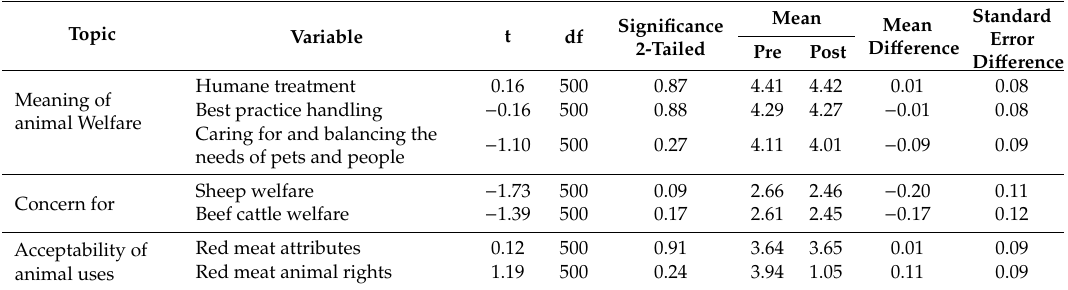
Table 6. Independent t-tests comparing the beliefs of the respondents pre and post the 60 Minutes programme in relation to the question “What does animal welfare mean to you?”. Responses based on composite